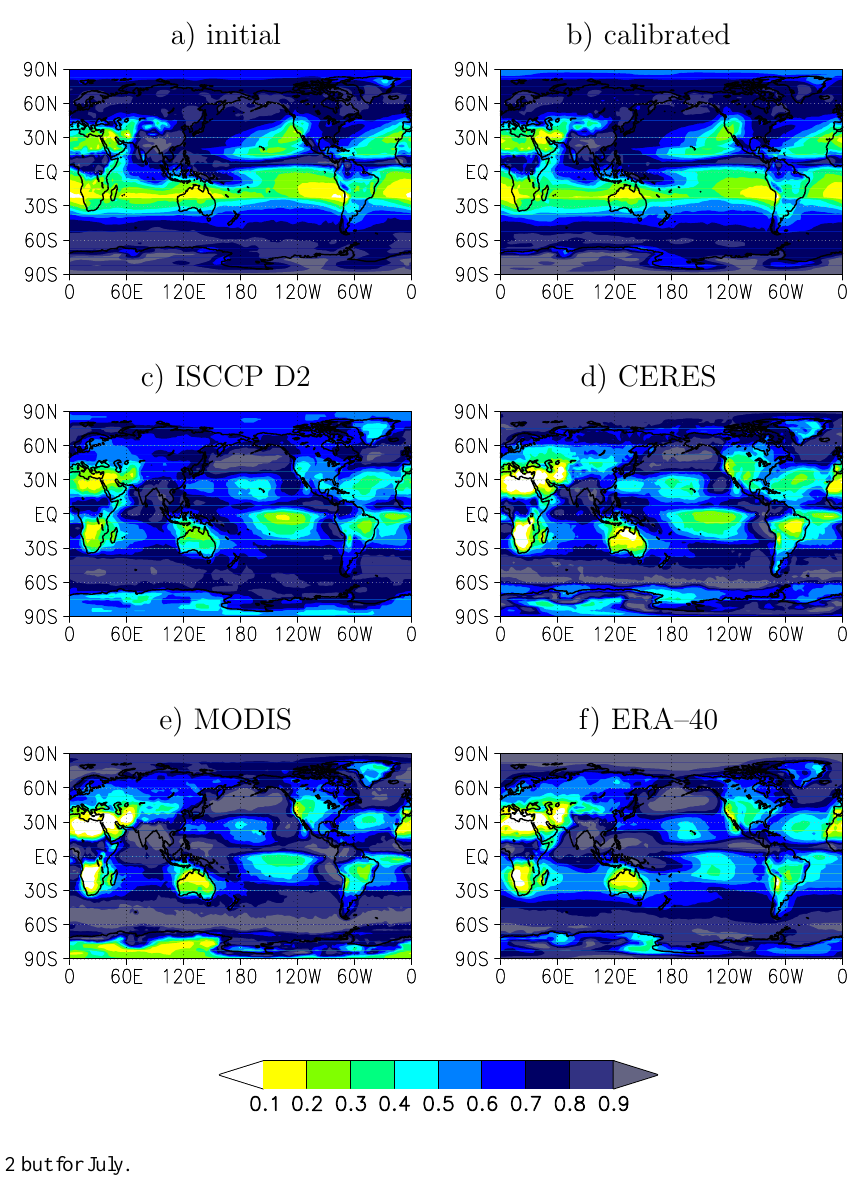
Fig. 4. Similar to Fig. 2 but for July.